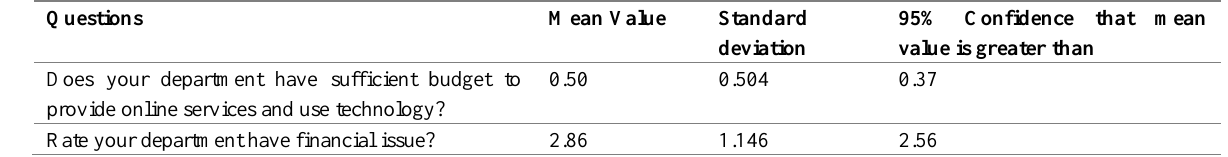
Table 14: Results of Questionnaire Processing Related to Financial